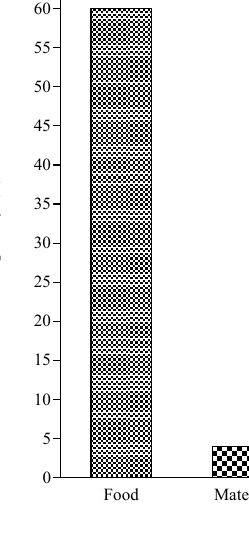
Figure 4. Distribution of use category of fruit species identified in three local communities of Bushbuckridge Local Municipality, Mpumalanga province, South Africa. # denotes number of mentions. Use category was based on the guideline prepared by Cook [28].